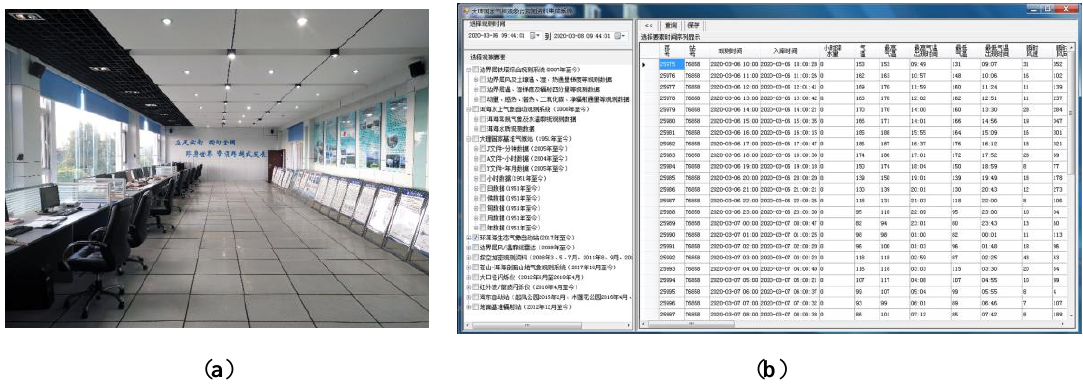
Figure 4. Operational platform ( a ) and database system ( b ) of the